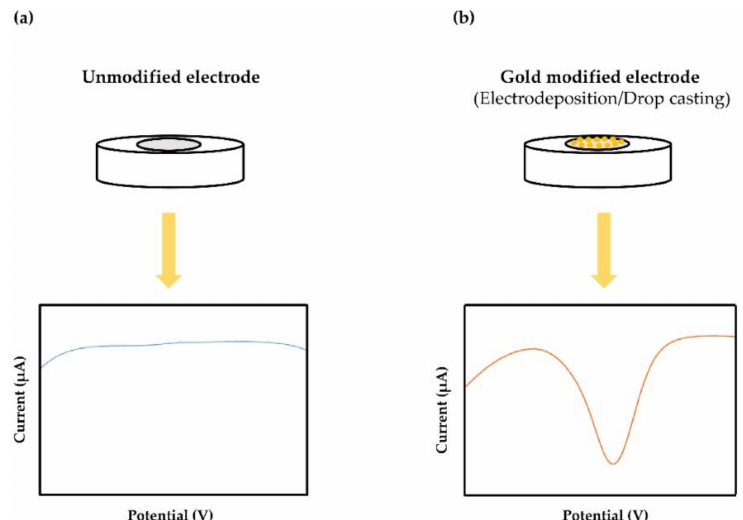
Figure 3. Typical response of Cr(VI) at: ( a ) unmodified; ( b ) AuNPs modified electrode using electrodeposition or drop casting